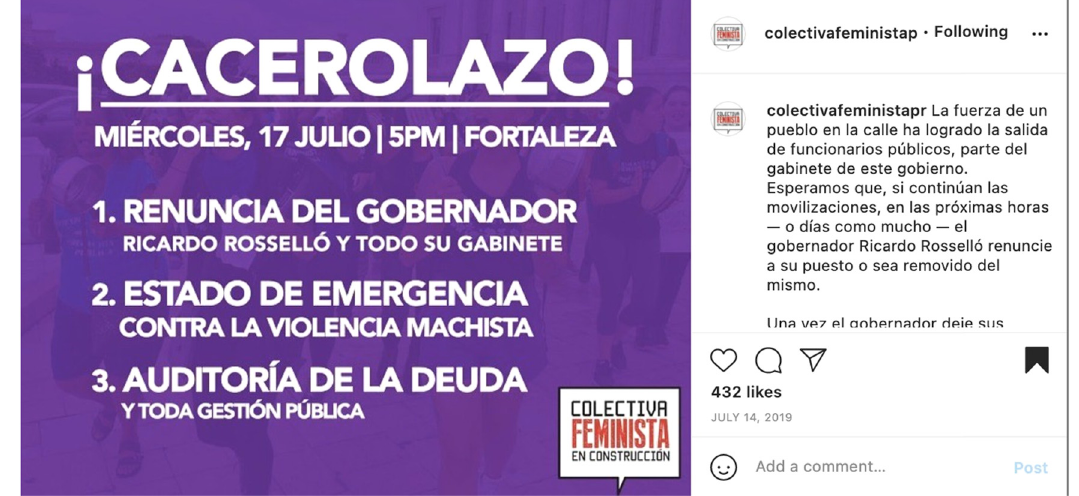
Figure 7: Screenshot from Colectiva Feminista en Construcción Instagram